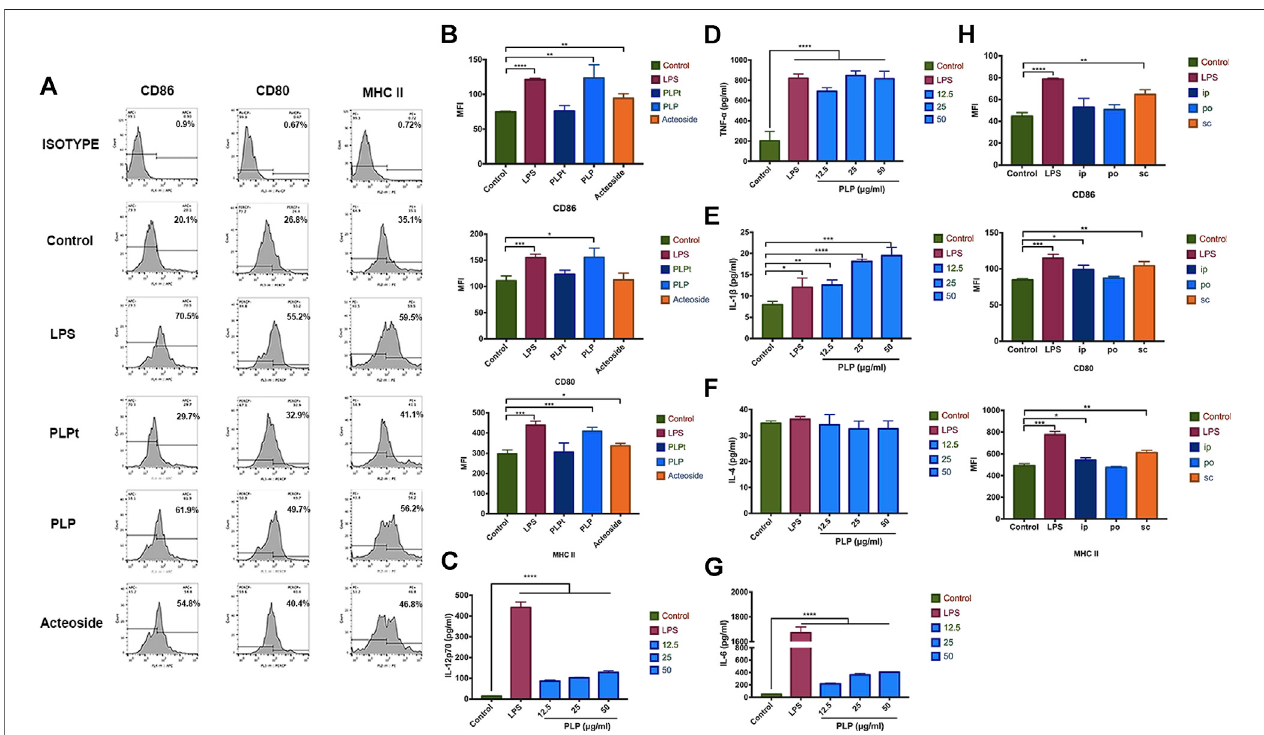
FIGURE 2 | PLP-activated DCs stimulated the expression of costimulator. (A) BMDCs were analyzed for expression of CD86 + , CD80 + , and MHC II + by fl ow cytometryafterstimulatedwith50 μ g/mlPLP,PLPt,andacteosidefor48 h. (B) Themean fl uorescenceintensity(MFI)ofthreesurfacemarkersCD86,CD80,andMHCII expression, respectively, in different groups. Secretion of IL-12p70 (C) , TNF- α (D) , IL-1 β (E) , IL-4 (F) , and IL-6 (G) from DCs treated with different formulations. (H) BMDCs were analyzed for the expression of CD86 + , CD80 + , and MHC II + by fl ow cytometry after stimulated with 10 mg/kg PLP via s.c., i.p., and p.o. for 48 h. All values shown are the average values from three independent experiments ± SEM (* p < 0.05, ** p < 0.01, and *** p <